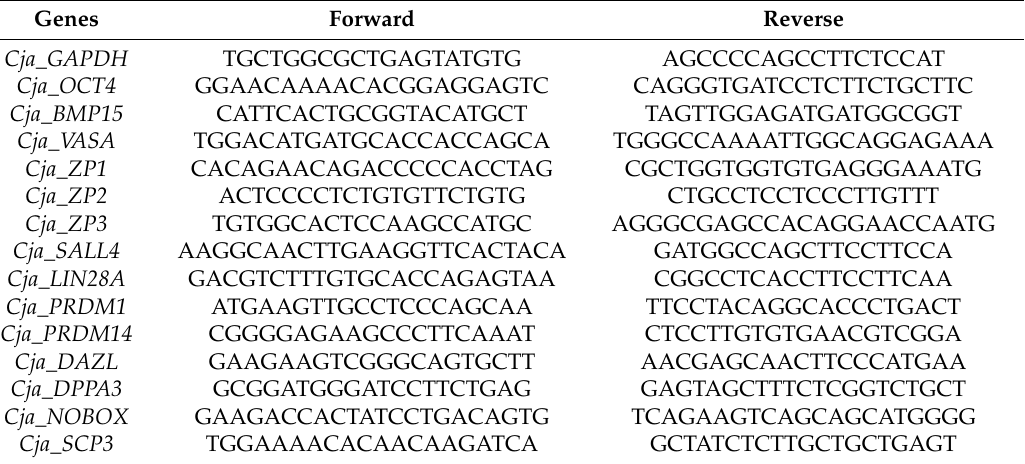
Table 3. Primer sequences for target gene